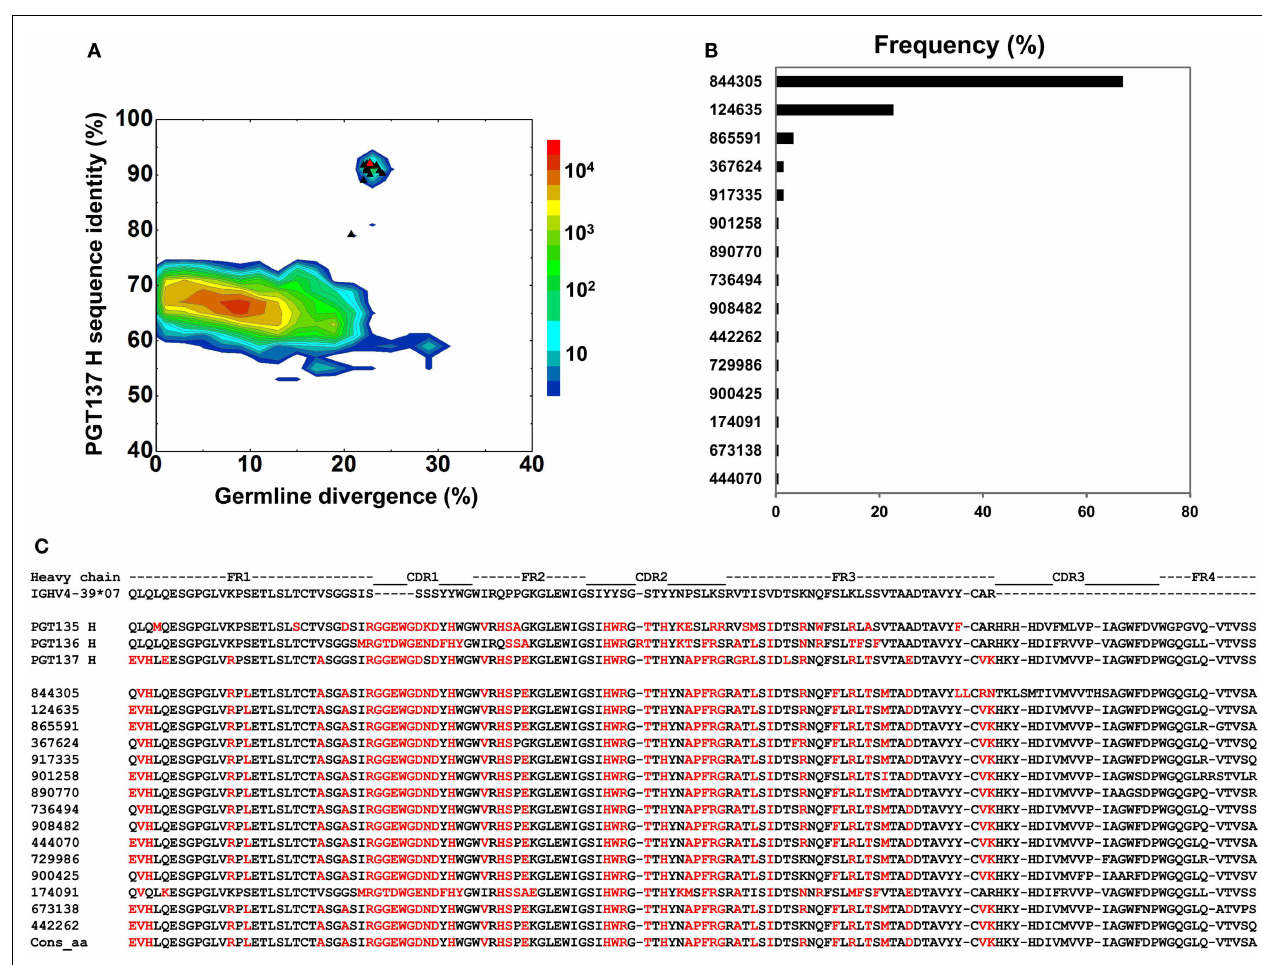
sequence identity cutoff of 95%. Each cluster is indicated by its representative sequence. “Frequency” refers to the total number of sequences observed for each cluster. (C) Protein sequences of 15 cluster representatives and their amino-acid consensus. Sequences are aligned to the inferred germline gene, IGHV4-39 ∗ 07. Framework regions (FR) and complementarity-determining regions (CDRs) are based on Kabat nomenclature. Amino acids mutated from the germline gene are shown in